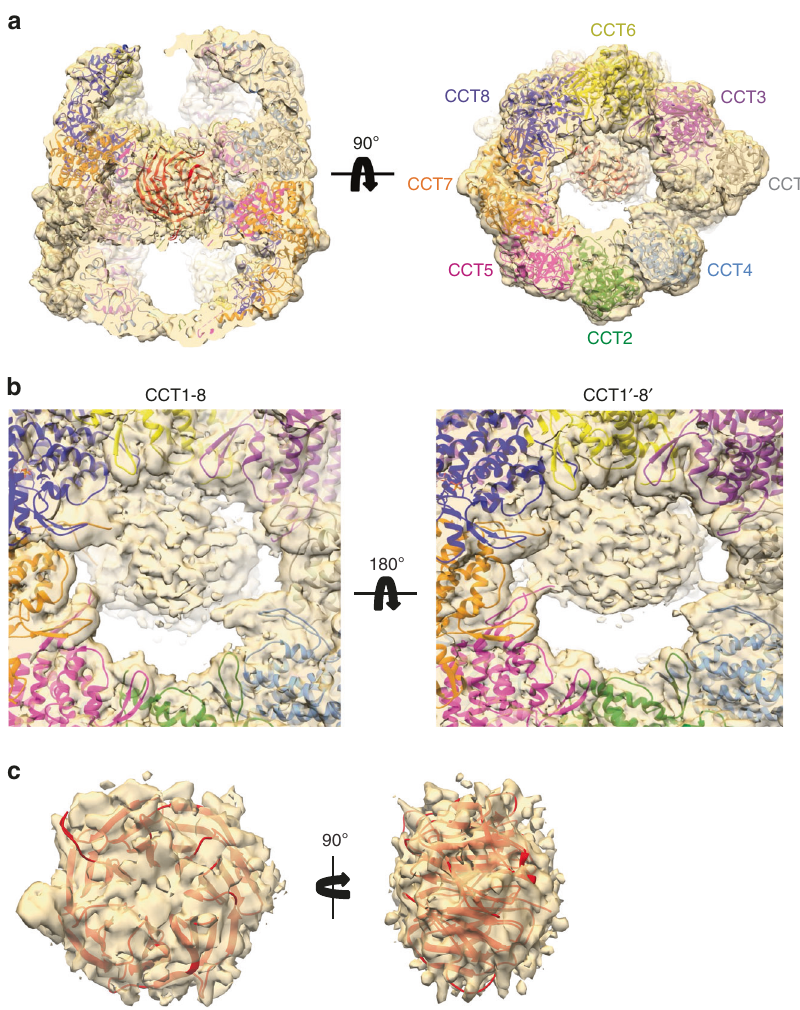
Fig. 4 Position of mLST8 within the mLST8 – CCT complex. a Docking of the atomic structure of mLST8 (red, PDB 4JT6) into the corresponding mass of the 3D reconstruction of the CCT – mLST8 complex. Left, sliced side view, and right, end-on view, show how mLST8 fi ts in the corresponding density. b Detailed views of the CCT subunits of each ring involved in mLST8 interaction, showing how the unstructured N- and C-termini of several subunits contact mLST8. Left, top ring, shows interactions with CCT5, CCT7, CCT8, CCT6, and CCT3, and right, bottom ring, with CCT5 ′ , CCT7 ′ , CCT8 ′ , CCT6 ′ , and CCT1 ′ . c The extracted cryo-EM density from between the rings with mLST8 docked shows the quality of the fi t of mLST8 into this